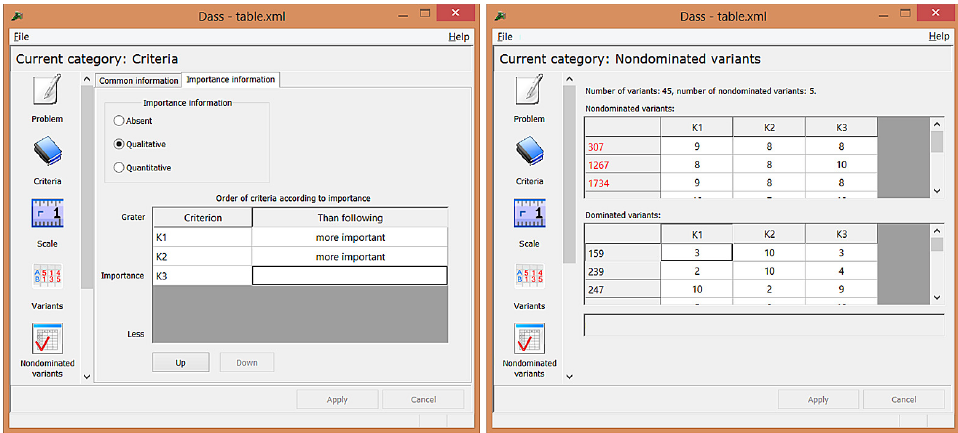
Figure 5. Non-dominated vector scores based on information about ordering criteria by